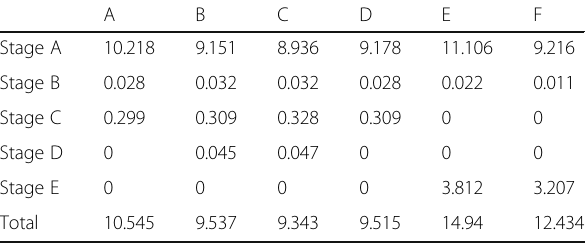
Table 5 Running time of stages of each posture (unit: ms)